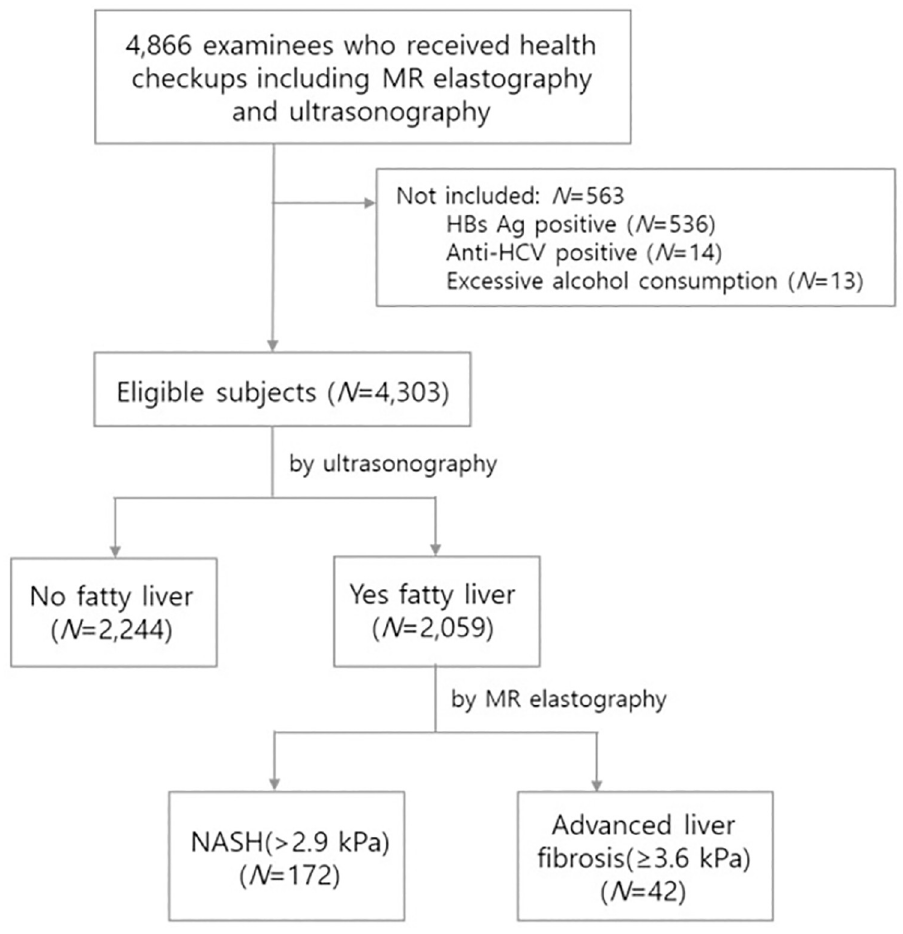
Fig 1. Flow chart of the